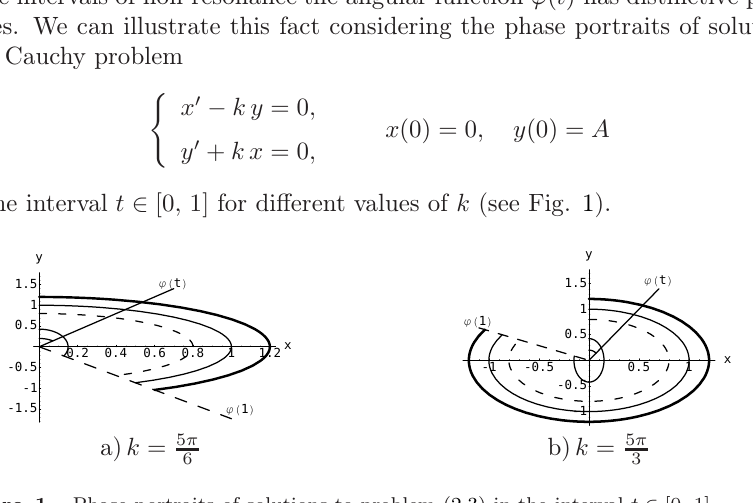
Figure 1. Phase portraits of solutions to problem (2.3) in the interval t ∈ [0 , 1] . If k ∈ (0 , π ) then the angular function ϕ ( t ) of solutions to the